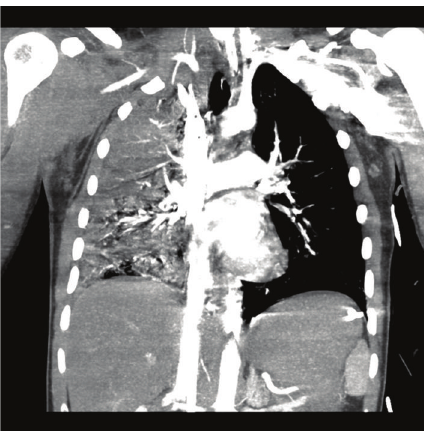
Figure 1: Computed tomography (CT) of the chest demonstrates extent of acute pulmonary injury.